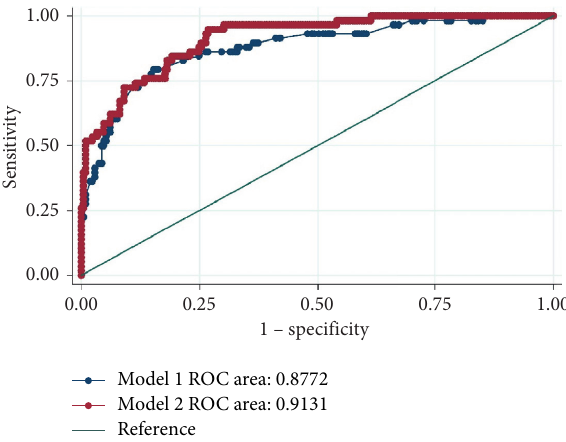
Figure 1: ROC comparing the performance of two models used in assessing the effect of lifestyle factors in predicting blood pressure control among urban